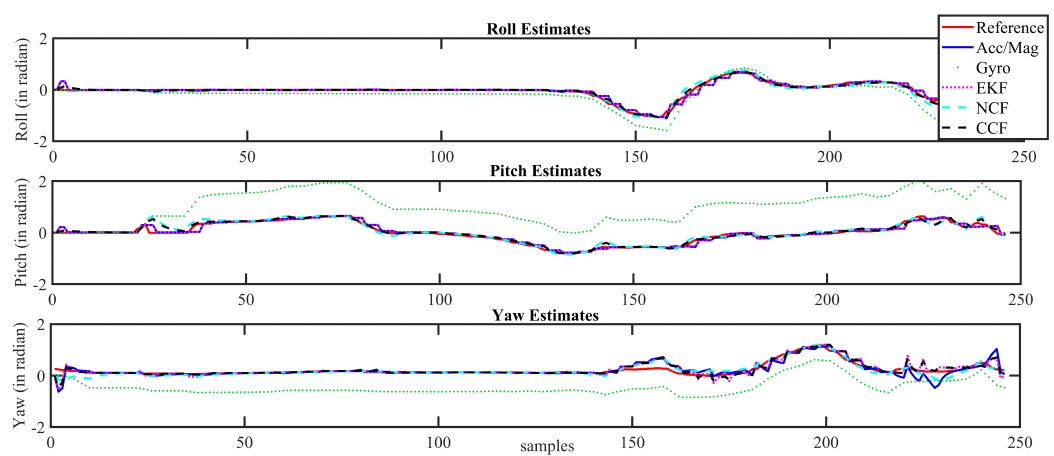
Figure 14. Attitude estimation results for Arducopter